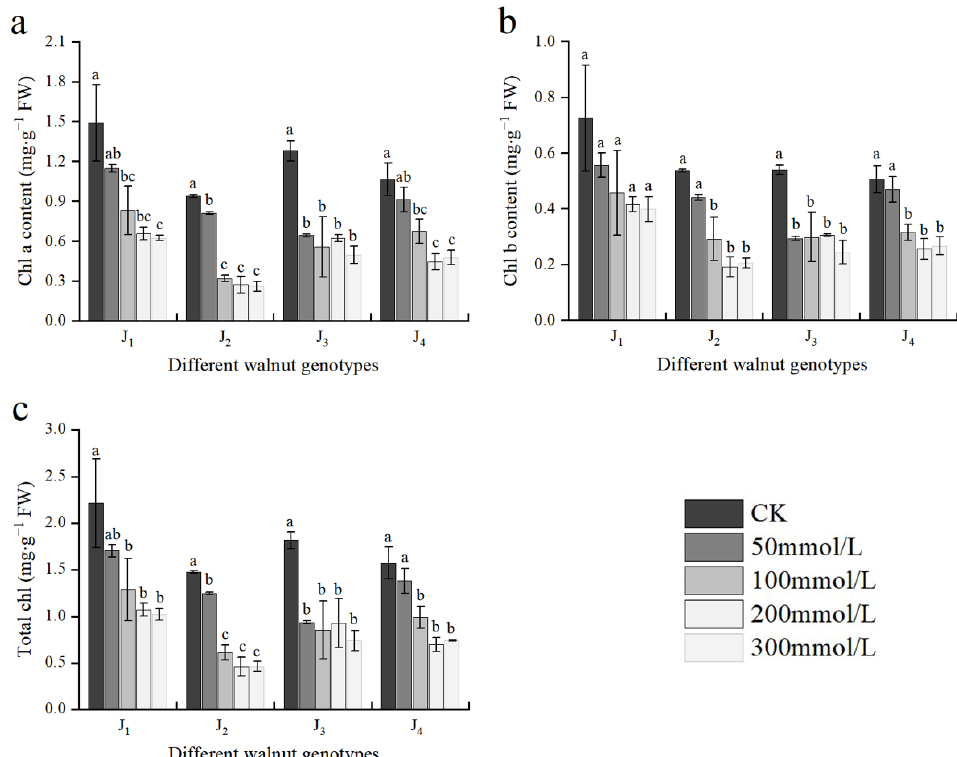
Figure 3. Effect of salt stress on the chlorophyll content of walnut. ( a ) Chlorophyll a content (Chl a), ( b ) chlorophyll b content (Chl b), and ( c ) total chlorophyll content (TChl) in the leaves. Four walnut genotypes were grown under different NaCl concentrations (0, 50, 100, 200, and 300 mmol/L) for 28 days. Each value indicates the mean ± standard error (SE) of three biological replicates. Bars of each parameter labeled with different letters are significantly different ( p < 0.05) by Duncan’s test.